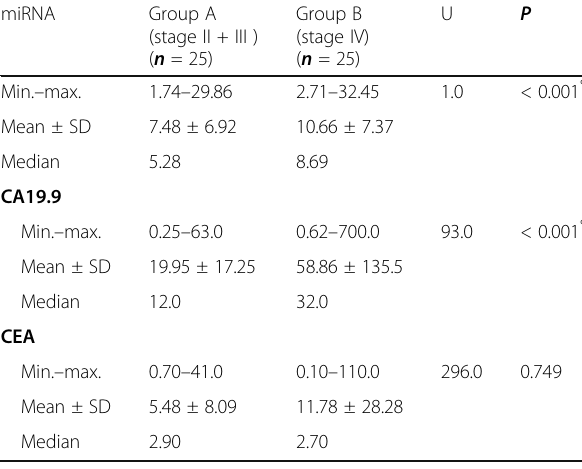
Table 4 Levels of microRNA 17-3P, CEA, and CA19.9 among group A and group B